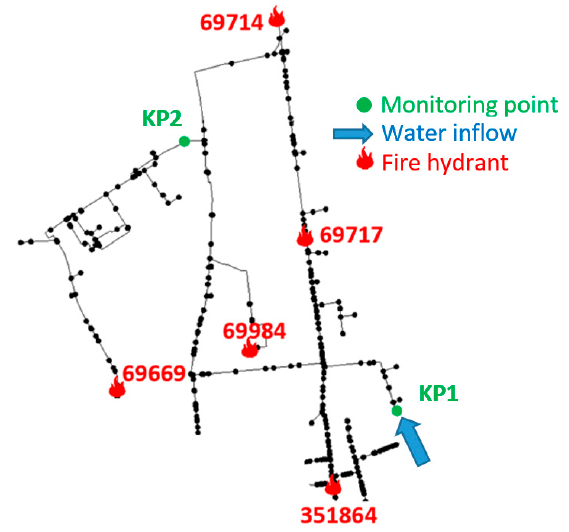
Figure 5. Location of monitoring points and open fire hydrants in the analysed DMA 02 zone.